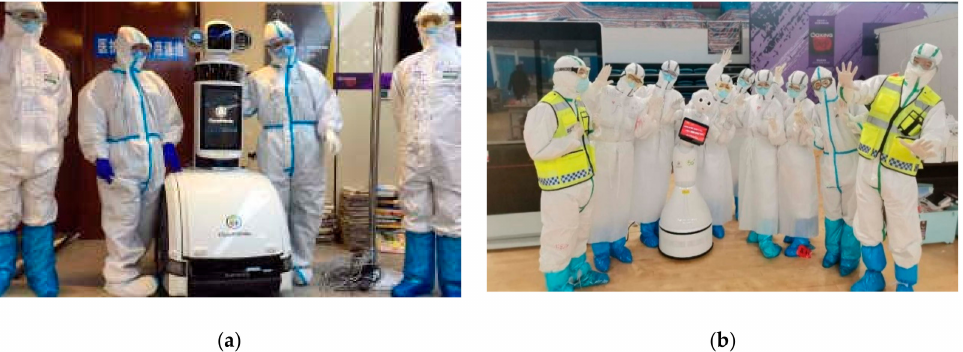
Figure 19. Reception robots in China during the COVID-19 outbreak. ( a ) Sterilization robot in Wuhan, China [83]. ( b ) Reception robot at a hospital ward in Wuhan, China